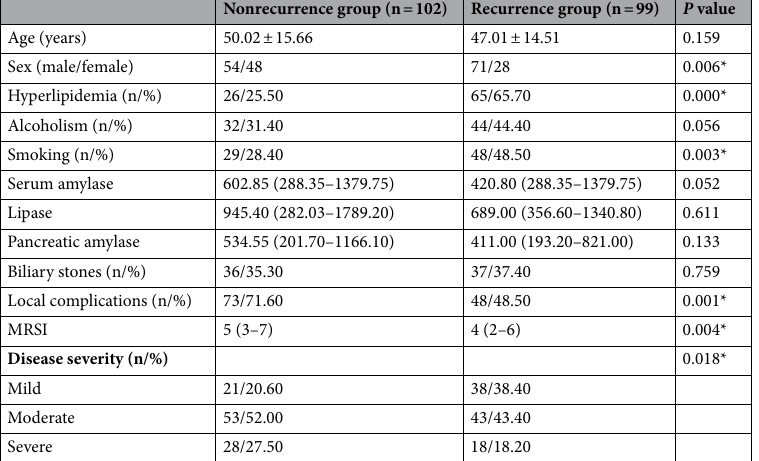
Table 1. Clinical characteristics of the nonrecurrence group and recurrence group. MRSI, MR severity index. * P value <